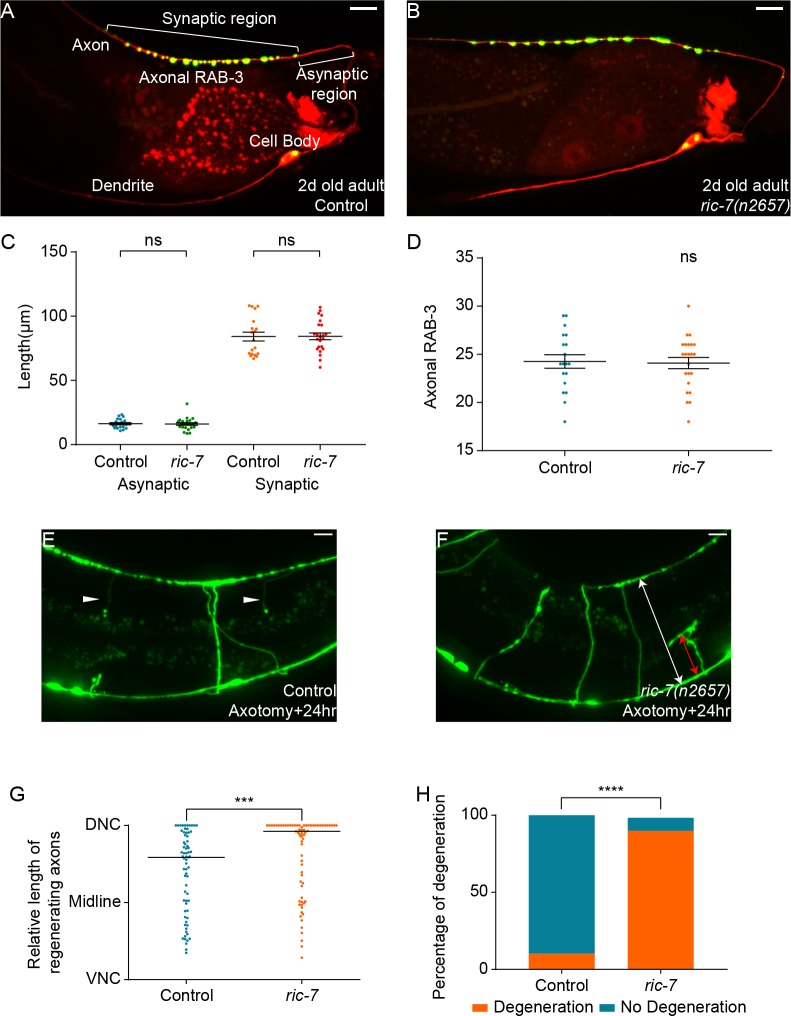
ric-7(n2657) animals show normal DA9 development, better regeneration and increased degeneration of GABA motor neurons.(A and B) GFP::RAB-3 and mCherry labeling in DA9 of control (A) and ric-7(n2657) (B) animals (2-day-old adults). Scale bars = 10 µm. (C) Length of the asynaptic region and the synaptic region in control and ric-7(n2657) animals (2-day-old adults). Mean ± SEM. ns, not significant. Unpaired t test. (D) Number of axonal RAB-3 puncta in control and ric-7(n2657) animals (2-day-old adults). Mean ± SEM. ns, not significant. Unpaired t test. (E and F) Regeneration and degeneration of GABA motor neurons in control (E) and ric-7(n2657) (F) animals 24 hr after axotomy. White arrowheads point to the remaining distal axon segments in control (E) which have degenerated in ric-7(n2657) (F). The red line in (F) indicates the length of the regenerating axon along the dorsal-ventral axis and the white line indicates the width of the animal. Scale bars = 10 µm. (G) Relative length of regenerating axons (the ratio of the length of red line and white line in (F)) in control and ric-7(n2657) animals 24 hr after axotomy. Black line is median. ***p<0.0001. χ2 test.